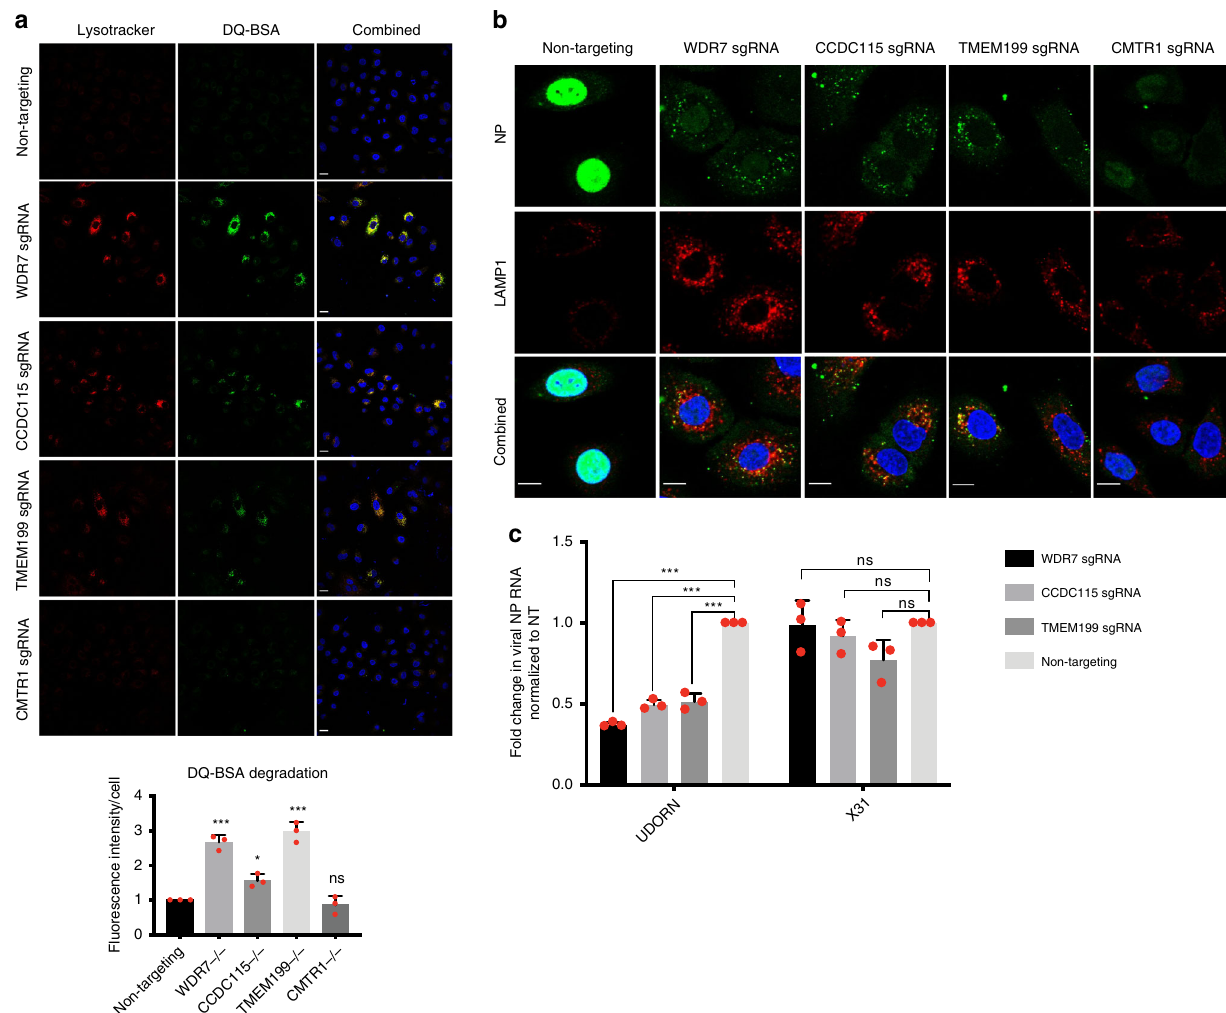
Fig. 6 Loss of WDR7, CCDC115 and TMEM199 prevents IAV nuclear entry. a Immuno fl uorescence staining of A549 cells transduced with either gene- speci fi c or non-targeting sgRNA with DQ-green bovine serum albumin (BSA) and Lysotracker red. Cells were treated with 20ug/ml DQ-BSA and Lysotracker red for 1 h at 37°C followed by fi xation to monitor uptake and hydrolysis of the DQ-BSA. DQ-BSA staining was quanti fi ed by dividing total fl uorescence intensity by the number of cells in each frame. Bar graph shows the relative fl uorescence intensity between different sgRNAs. Scale bar = 20 μ m. Error bars represent standard deviation from three randomly chosen frames. b Immuno fl uorescent staining of A549 cells transduced with either gene-speci fi c or non-targeting sgRNA with FITC-conjugated anti-H1N1 NP antibody. Cells were infected with PR8 virus at MOI 500 for 2 h at 37°C. Scale bar = 15 μ m. c Fold change in viral NP RNA level relative to GAPDH measured by qRT-PCR. A549 cells transduced with gene-speci fi c or non-targeting sgRNA were infected with either in fl uenza H3N2 Udorn or X31 virus at MOI 5 for 16h. Fold change was normalized to viral NP RNA level in A549 cells transduced with non-targeting sgRNA. Error bars represent standard deviations from three independent experimental replicates. *** P < 0.001 and * P < 0.05, by one-way ANOVA